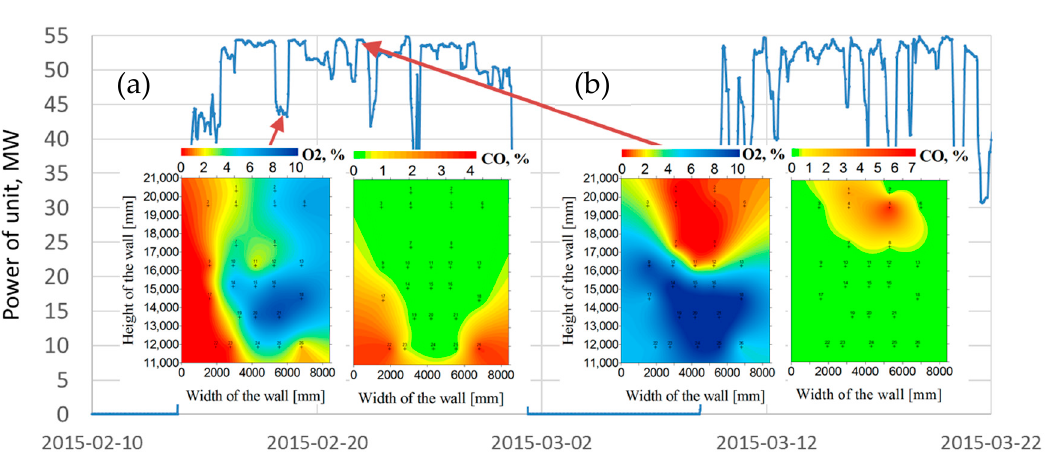
Figure 9. Changes in the electric power of the block and examples of O 2 and CO concentrations near the front wall for two di ff erent boiler operation variants (( a )–44MW, ( b )–53MW). The scale of the maps is from 0 to 10% for O 2 and from 0 to 4% for CO, respectively.